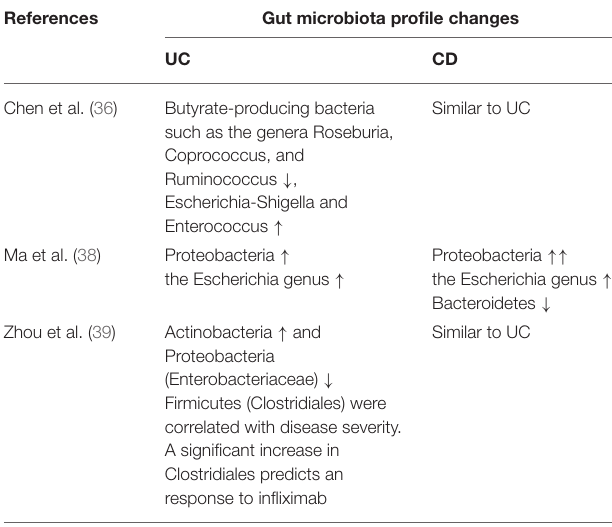
TABLE 2 | Changed gut microbiota profile in Chinese